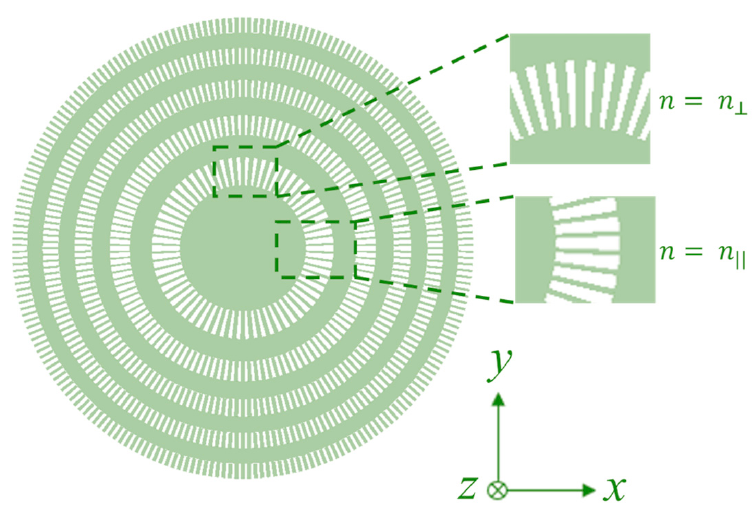
Figure 4. Top-view diagram of our proposed polarization-specific binary phase Fresnel zone plate using subwavelength gratings (SWGs). Note that the duty cycles of the SWGs in each ring depend on the orientation of the segments.